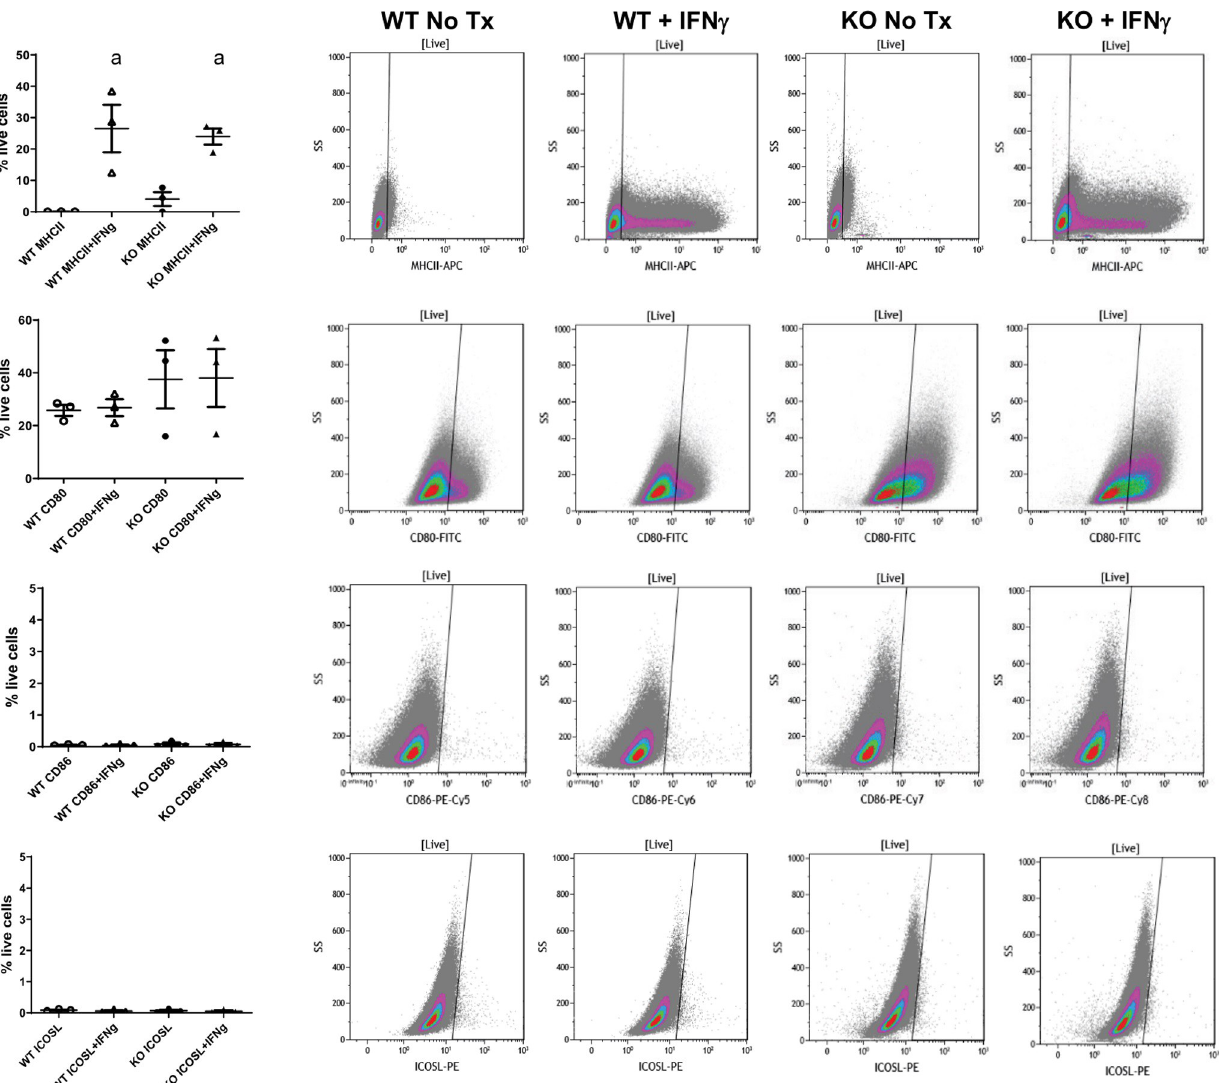
Fig 1. MCH II and co-stimulatory marker expression in cell lines in WT and FcRn KO podocytes. Flow cytometry data showing MHC II, CD80, CD86 and ICOSL expression in WT and FcRn KO podocytes at baseline and after treatment with IFN γ . Treatment with IFN γ results in increased MHCII expression in WT and KO podocytes (a, p = 0.0036). Both WT and FcRn KO podocytes express CD80 at baseline and this is not significantly increased after treatment with IFN γ . WT and FcRn KO podocytes do not express CD86 or ICOSL at baseline or after treatment with IFN γ (n = 3 to 4 experiments for all